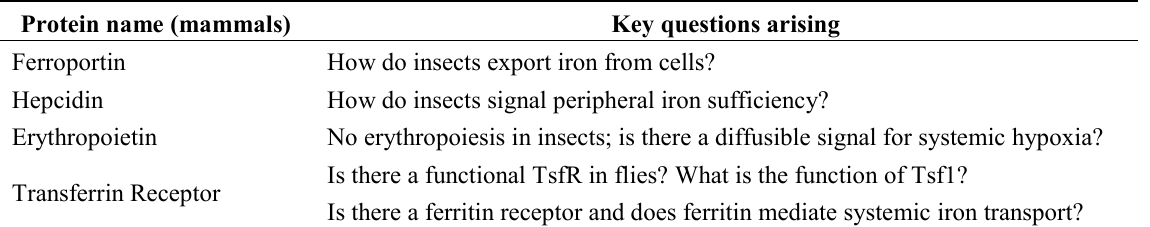
Table 3. Mammalian iron metabolism proteins with no orthologs in Drosophila